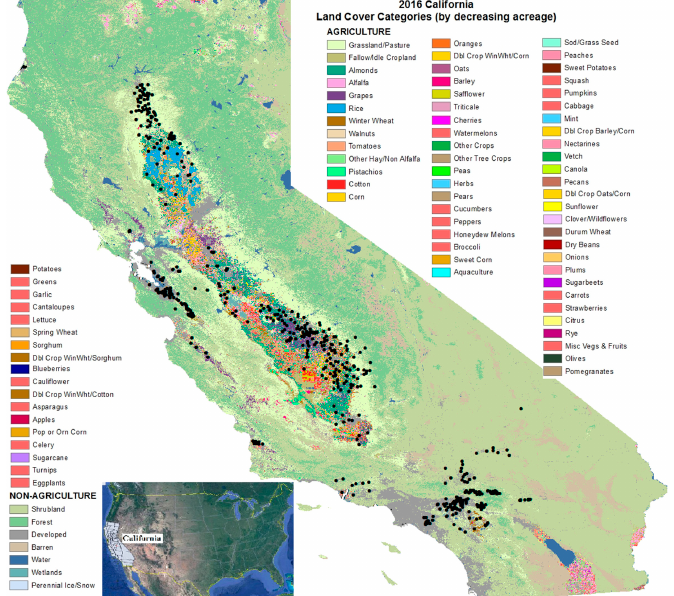
Figure 1. California map showing all sample points used in this study. Color variation is from the USDA Cropland Data Layer. Most of the samples are concentrated within California’s Central Valley, which produces a high volume and diverse selection of agricultural products. The Farmland Mapping and Monitoring Program (FMMP) layer, which is not shown here, was used to define areas of confined animal agriculture, and to cross-check Cropland Data Layer (CDL)